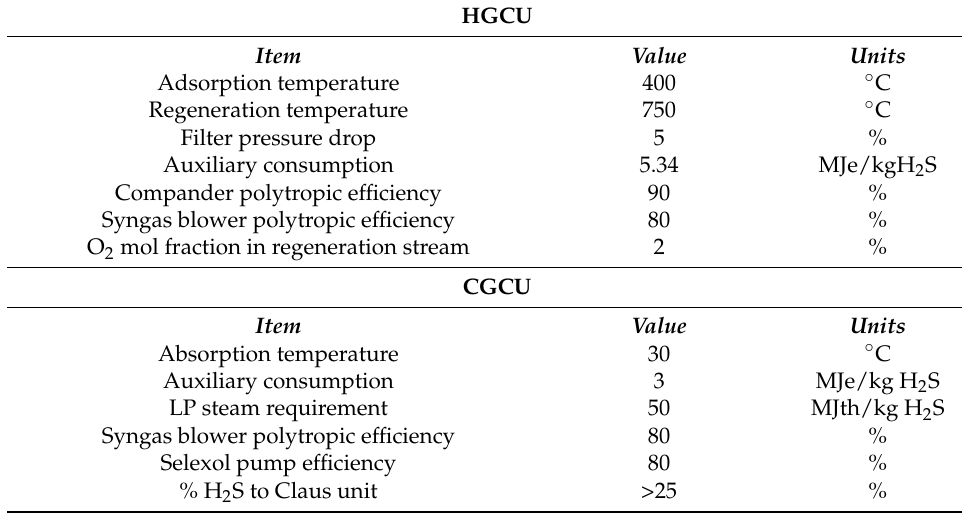
Table A2. Syngas treating unit assumptions.